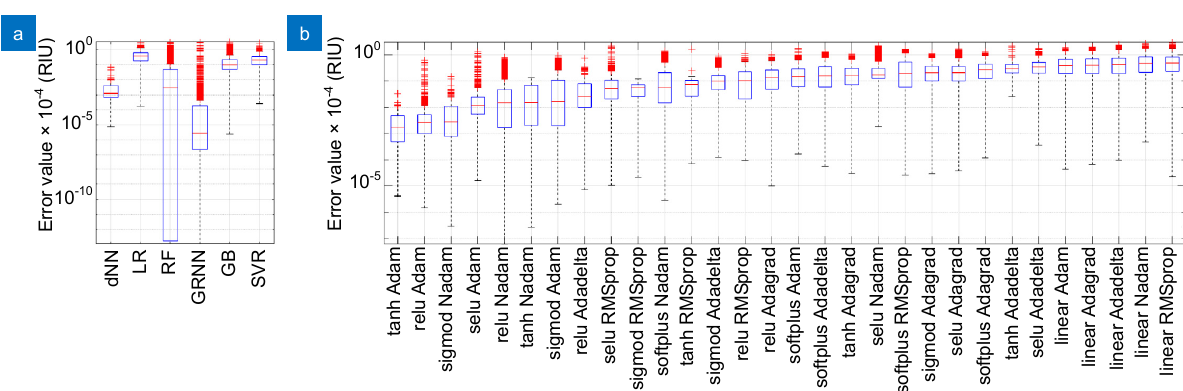
Fig. 5 | ( a ) Distribution of the absolute error values between the measured refractive indexes and the values predicted with different processing approaches: deep neural network (dNN), linear regression (LR), random forest (RF), general regression neural network (GRNN), gradient boost- ing (GB), and support vector regression (SVR). ( b ) Statistics on the performance of the refractive index prediction with dNN approach with differ- ent combinations of weights optimization methods (Adam, RMSprop, Nadam, Adagrad, and Adadelta) and activation functions (tanh, sigmoid, relu, selu, linear, and softplus).